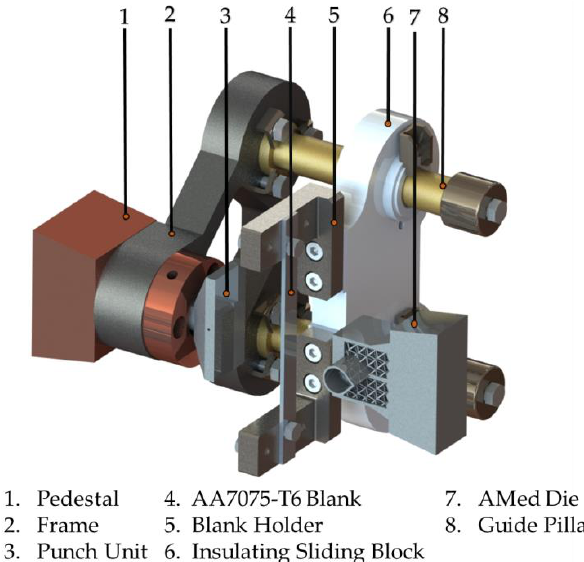
Figure 4. Testing facility used for the thermal response of AM hot stamping dies .